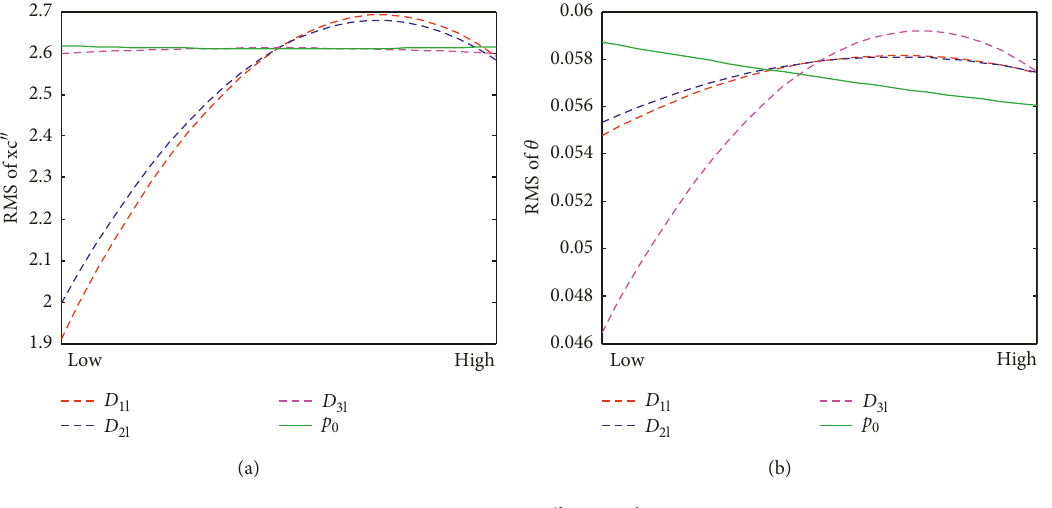
Figure 7: Main effect